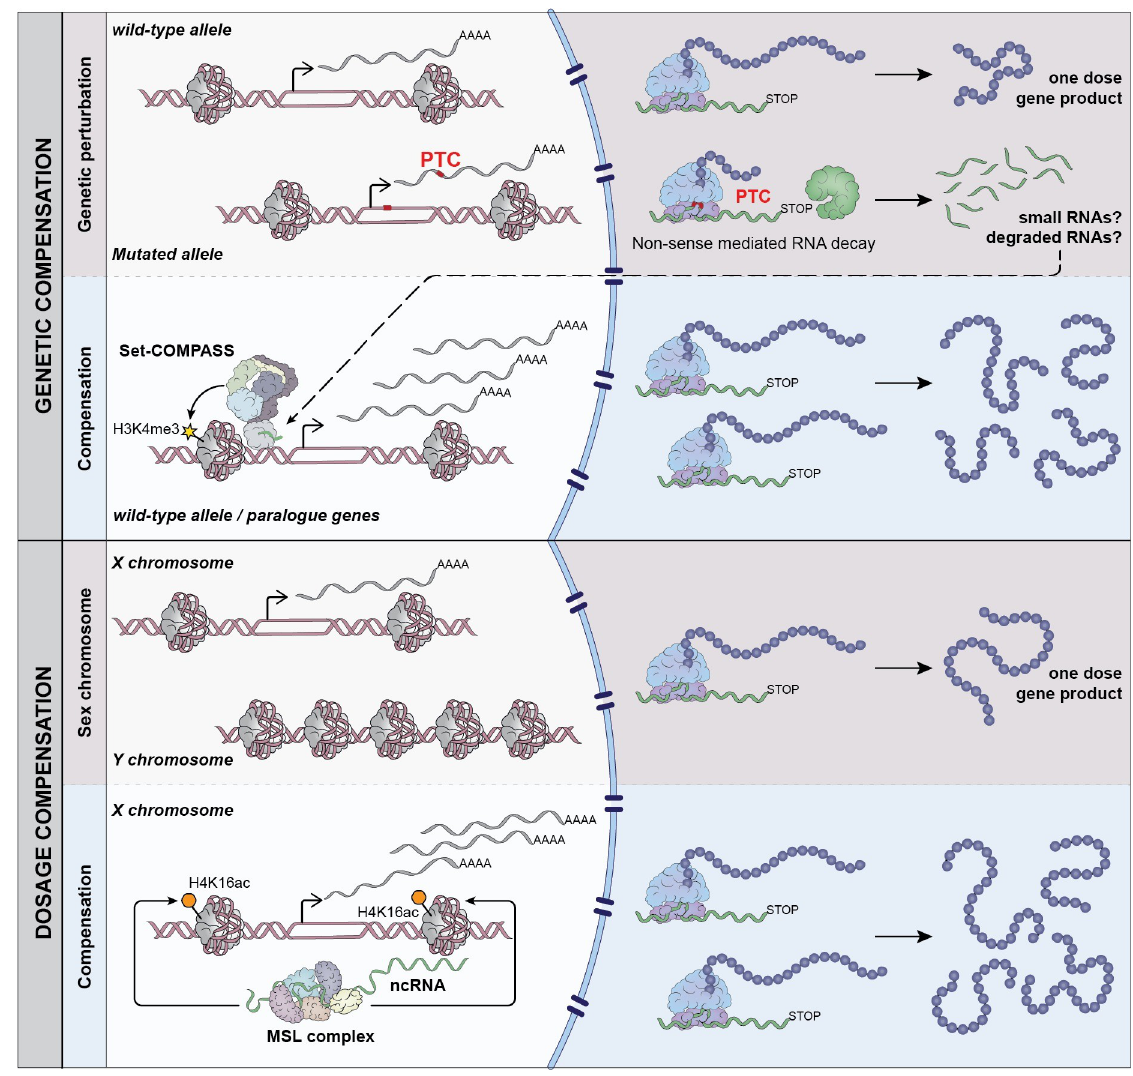
Fig 4. Comparison of genetic compensation and X chromosome DC. The illustration shows the genetic compensation mechanism, where a premature termination codon in the DNA, produces an RNA, which is exported to the cytoplasm. Upon translation, the premature termination codon-containing transcript is recognized as “faulty” by the NMD pathway and degraded. It is assumed that the degradation products (small RNAs?) can signal back to the corresponding locus in the nucleus, which promotes an increase of Histone H3 Lysine 4 trimethylation (H3K4me3) at the promoter of the (a) unaffected allele; and (b) of gene paralogues that have sequence similarity to the original locus. This can then enhance transcription, which functionally rescues the effects of the original mutation. In Drosophila DC, noncoding RNAs are produced in cis from the hemizygous X chromosome in males. This induces the recruitment of the MSL2 protein of the MSL complex. The MSL complex acetylates Histone H4 Lysine 16 (H4K16ac), which triggers the chromatin decompaction and promotes transcription of expressed genes on the X. DC, dosage compensation; NMD, nonsense mediated